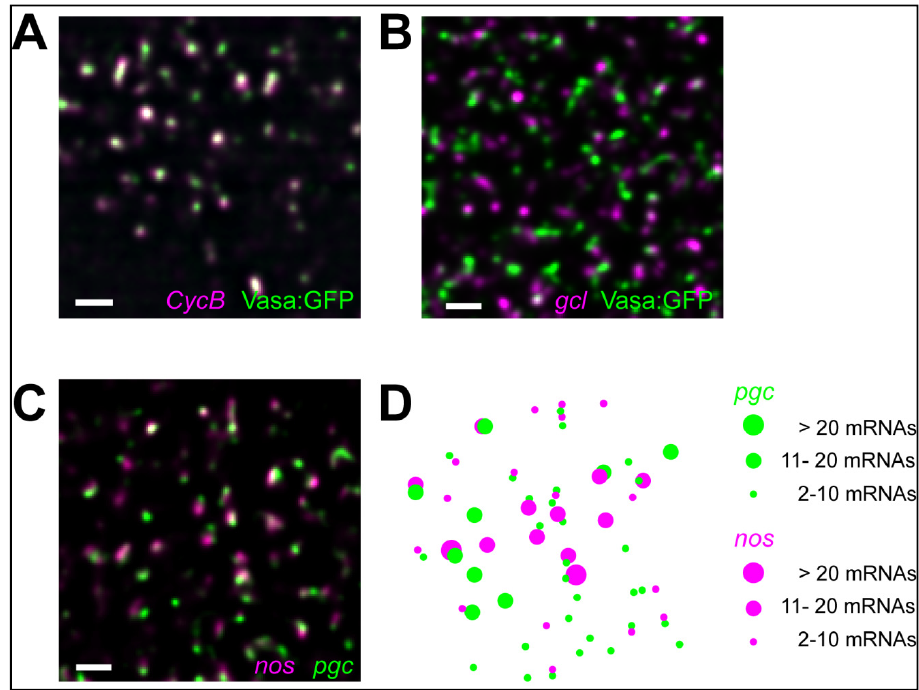
Figure 3. ( A , B ) CycB and gcl mRNA clusters (magenta; hybridized with smFISH probes) occupy distinct positions within Drosophila germ granules (green, labeled by Vasa fused with GFP). ( C , D ) Homotypic clusters contain multiple nos or pgc mRNAs (magenta and green, respectively hybridized with smFISH probes), do not have a defined stoichiometry and de-mix from each other within the same granule [85]. Scale bar in all is 1 µm.